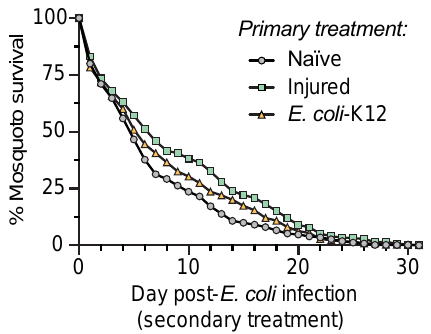
Figure 6. Mosquito survival after the secondary treatment. Five days after the primary treatment of naïve, injury, or infection with E. coli -K12, all the mosquitoes were infected with E. coli -GFP and their survival was tracked every day until all the mosquitoes had died.